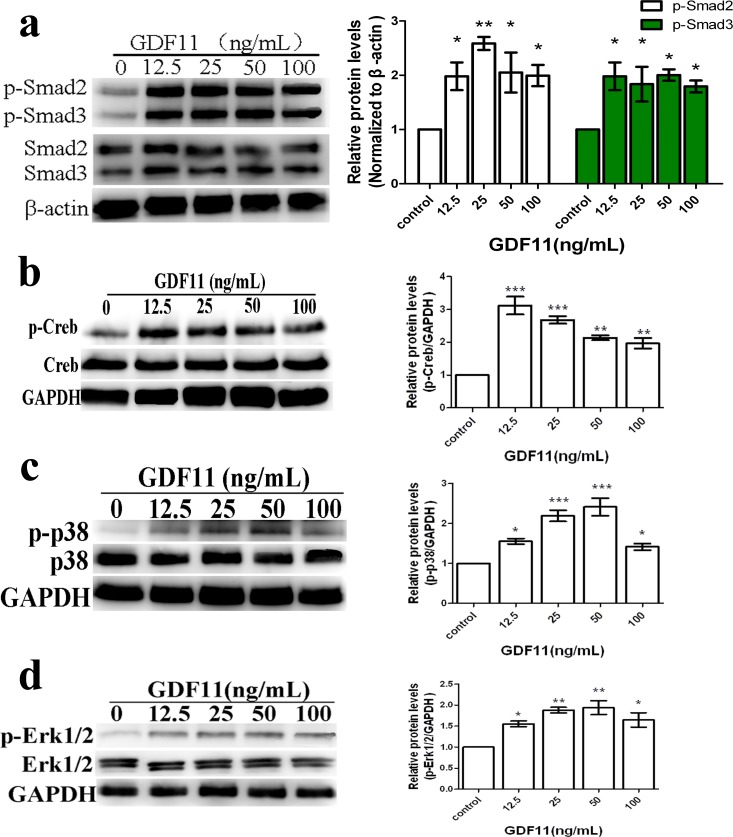
GDF11 increased the phosphorylations of Smad2/3, Creb, p38 and Erk in C17.2 neural stem cells.(A–D). After 24 h cultivation, GDF11 showed no effect on total protein of Smad2/3, Creb, p38 and Erk, but significantly phosphorylated Smad2 (Ser465/467), Smad3(Ser423/425), Creb(Ser133), p38(Thr180/Tyr182) and Erk (Thr202/Tyr204) in C17.2 cells. N = 4, *p < 0.05, **p < 0.01 and ***p < 0.001 when compared with control.